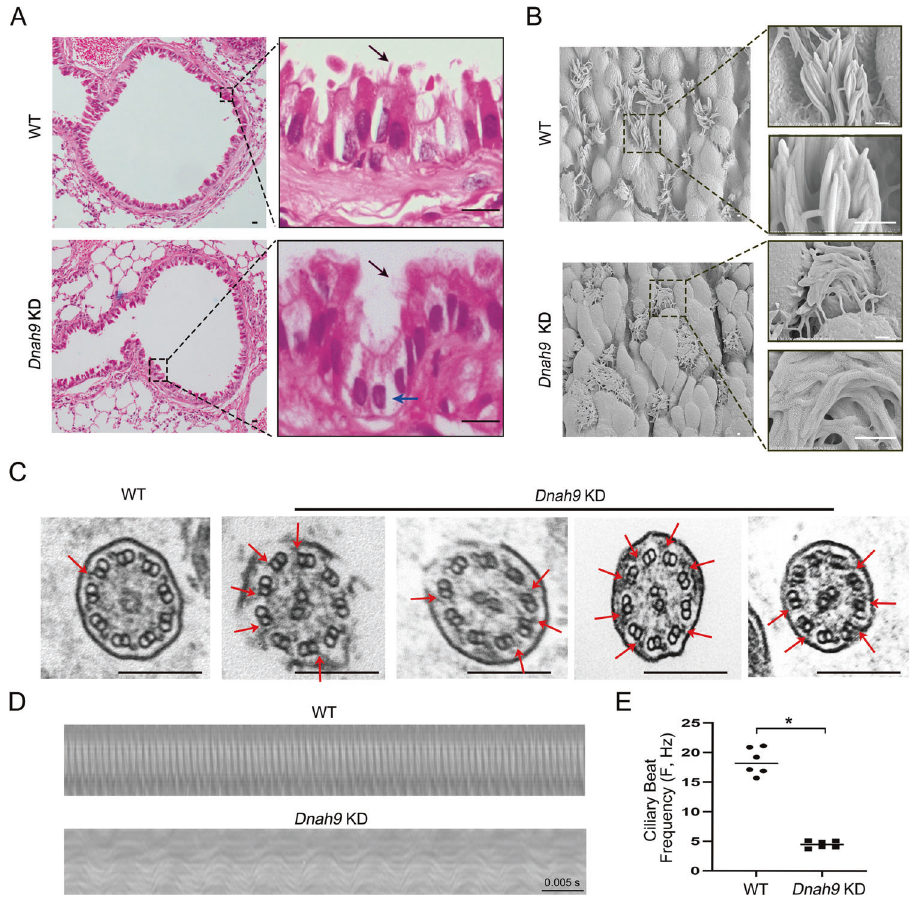
Fig. 5 Abnormal cilia structure and function in Dnah9 KD mice. A H&E staining of bronchi in lung sections in WT and Dnah9 KD mice at 40 days old. Compared to the WT, the tracheal epithelia of Dnah9 KD mice show vacuolization (blue arrows), and the distribution of cilia seems more clustered (black arrows). Boxed regions on the right depict higher magni fi cations. Scale bar = 10 μ m. B The SEM showing surface of tracheal epithelia from WT and Dnah9 KD mice. Boxed regions are shown at higher magni fi cation on the right. Scale bar = 9 μ m. C TEM images of tracheal epithelium cilia for WT and Dnah9 KD mice. The axonemal structure is regular but shows a partially distal absence of ODAs in tracheal epithelium cilia of Dnah9 KD mice (red arrow). Scale bar = 200 nm. D Representative kymograph of 40-day-old WT and Dnah9 KD nasal cilia from high-speed video microscopy study. Scale bar = 0.005 s. E The CBF of Dnah9 KD mice is signi fi cantly reduced compared with WT mice. * P < 0.05. n = 6 per mice (Fig. 6C). Co-IP assays revealed that both CCDC114 and GAS8 nexin-dynein regulatory complex (N-DRC) in multiciliate cells from interacted with DNAH9 (Fig. 6D). Our results collectively demon- nasal tissue. Notably, our immunostaining results showed the strate that DNAH9 implements the ODA function, possibly by expression of GAS8 and CCDC114 in cilia was dramatically cooperating with CCDC114 and GAS8. decreased upon deletion of DNAH9 (Fig. 6A, B), indicating a structural impairment in the ODA-DC and N-DRC in Dnah9 KD The airway organoid model from Dnah9 KD mice can mice. In contrast, dynein axonemal assembly factor 11 (LRRC6) phenocopy the patient with PCD was not obviously affected. Furthermore, western blot analysis Epithelial cells from WT and Dnah9 KD mice were observed to showed that the expression of CCDC114 was signi fi cantly reduced form hollow spherical tracheas, which is a typical morphology of in KD mice, and GAS8 expression also showed a decreasing trend, trachea organoids (Fig. 7A). Consistent with the results mentioned though no signi fi cant differences were found between WT and KD